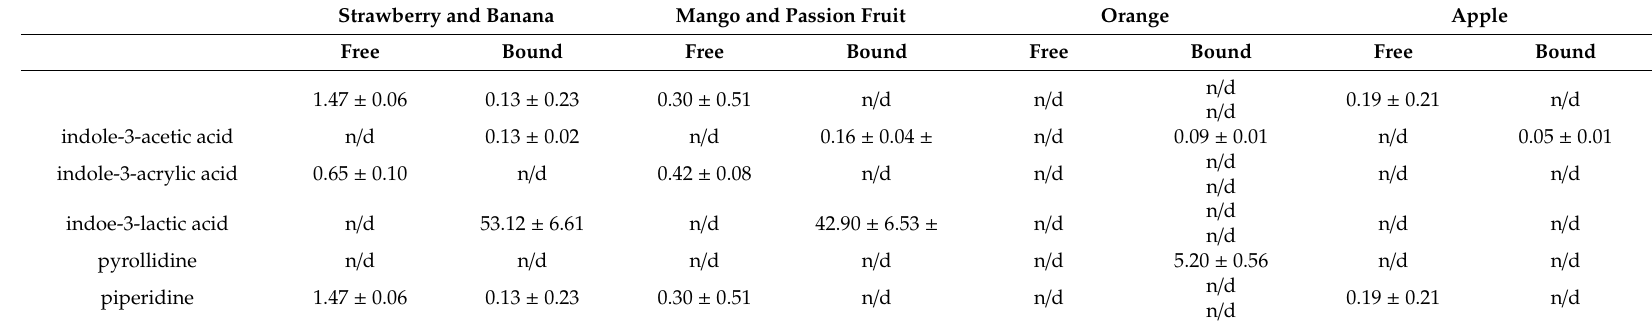
Table 5. Indole and polyamine content of juice / smoothie samples.